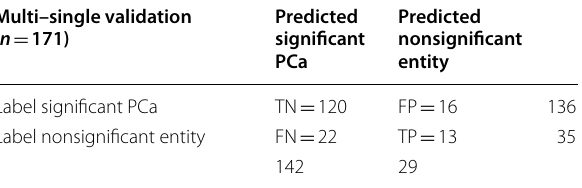
Table 4 Confusion matrix for the multi–single